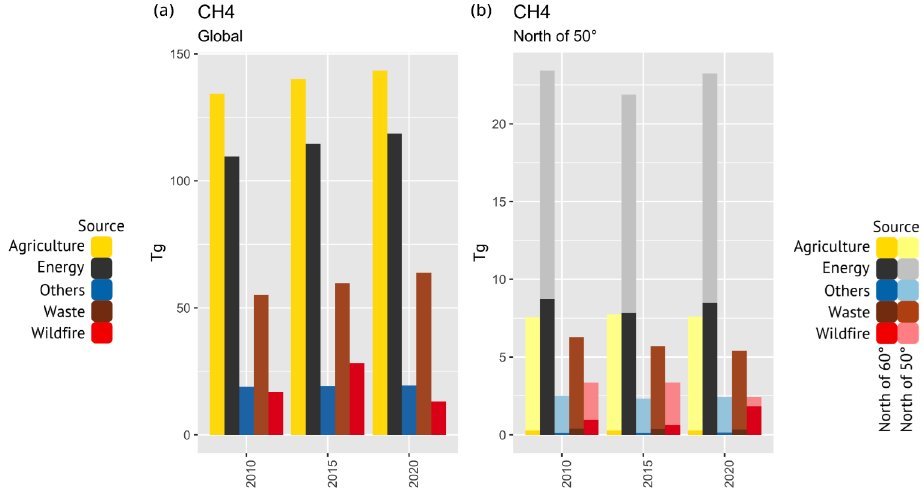
Figure 6. Annual CH 4 emissions for 2010, 2015, and 2020 from anthropogenic source sectors (agriculture and energy including flaring, waste, and others) from GAINS and wildfires from GFAS, presented globally (a) and (b) at 50 to 60 ◦ N (lighter colours of the cumulative bar) and north of 60 ◦ N latitude (darker colours of the cumulative bar).